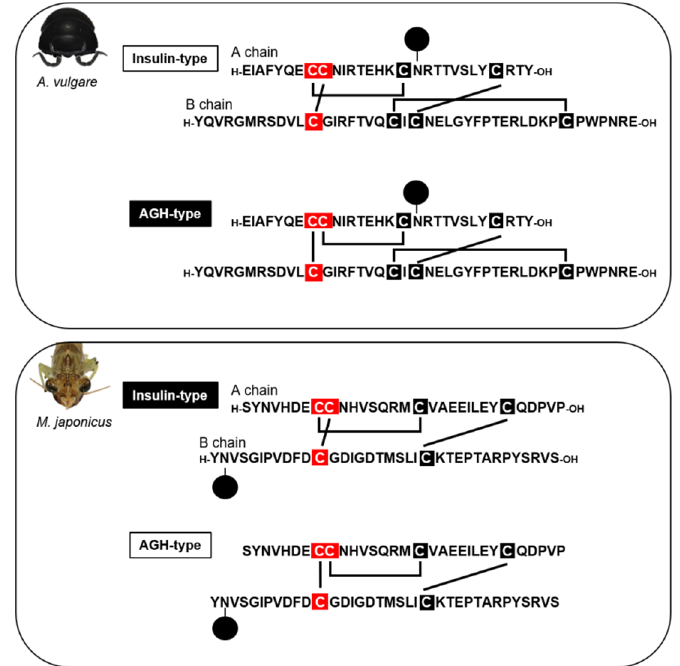
Figure 3. Primary structures of IAG peptides in the woodlouse A. vulgare (upper) and the kuruma prawn M. japonicus (lower). Each upper and lower shows the insulin-type and AGH-type, respectively. Solid lines show the disulfide bond pairs, and cystein residues in the red box indicate the different patterns between insulin-type and AGH-type. Black-highlighted types (AGH-type in A. vulgare and insulin-type in M. japonicus ) are the estimated bioactive forms, respectively. ● : sugar chain.